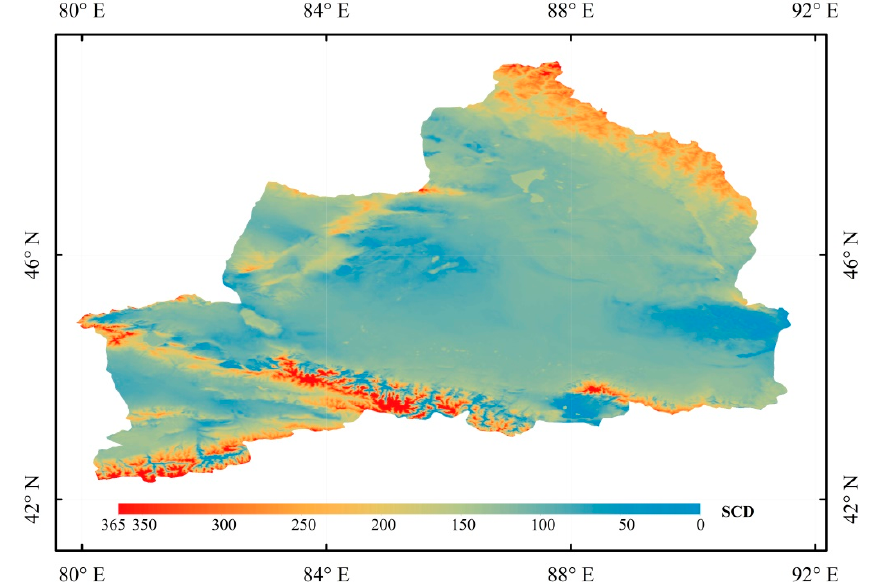
Figure 8. The mean snow cover days (SCD) from 2000 to 2018 in northern Xinjiang, China.